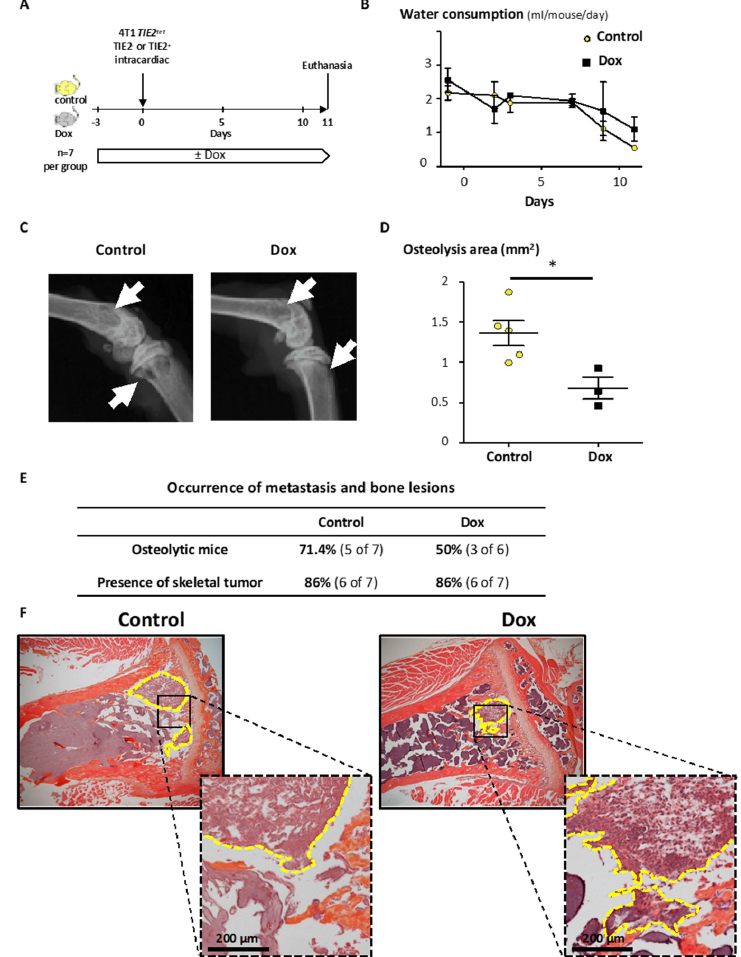
Figure 8. TIE2 reduces osteolysis of 4T1 TIE2 tet bone metastasis. ( A ) 4T1 TIE2 tet cells were cultured in the presence or absence of doxycycline for 2 days before being inoculated in the left cardiac ventricle of mice receiving or not doxycycline in their drinking water (n = 7 per group). ( B ) Water consumption was measured throughout the experiment. Osteolytic lesions were assessed using ( C ) radiographs of the hind limbs of mice (white arrows indicate osteolysis area), and ( D ) the osteolysis area was measured. * p < 0.05 using a Mann–Whitney test. ( E ) Summary of the occurrence of osteolytic lesions on endpoint radiographs and of skeletal tumor burden on tissue sections. ( F ) The presence of skeletal tumor burden was assessed using tissue sections stained with hematoxylin, eosin, and orange G (representative sections). The yellow dotted lines contour and indicate the skeletal tumor